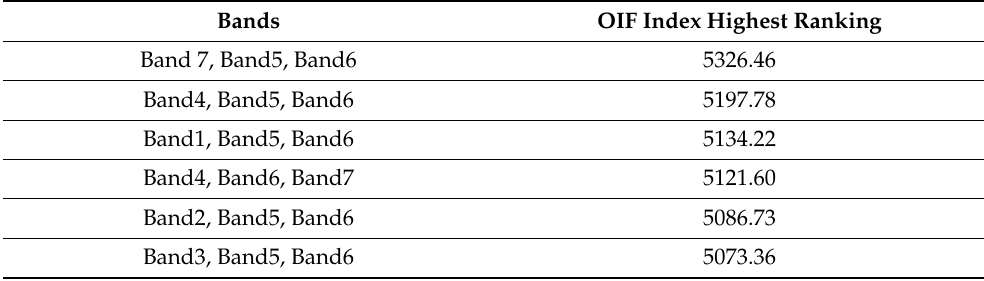
Table 2. Values OIF index to determine the best False Color